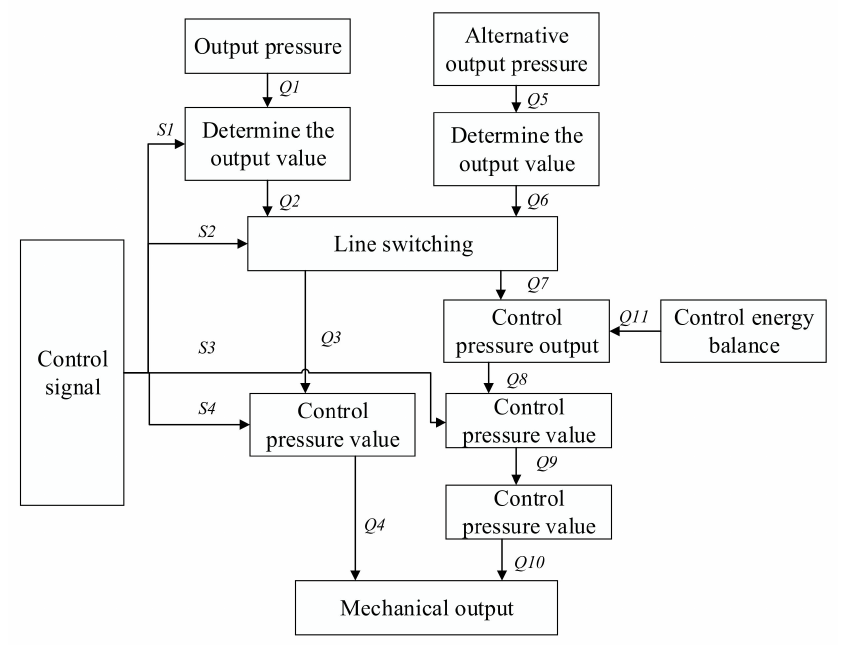
Figure 4. Function Model of Brake System. ( Q 1 – Q 11 : the flow of the components; S 1 – S 4 : the signal of the